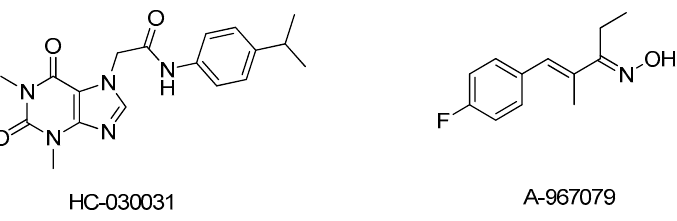
Figure 1. Chemical structure of Hydra Biosciences (HC-030031) and Abbott (A-967079).